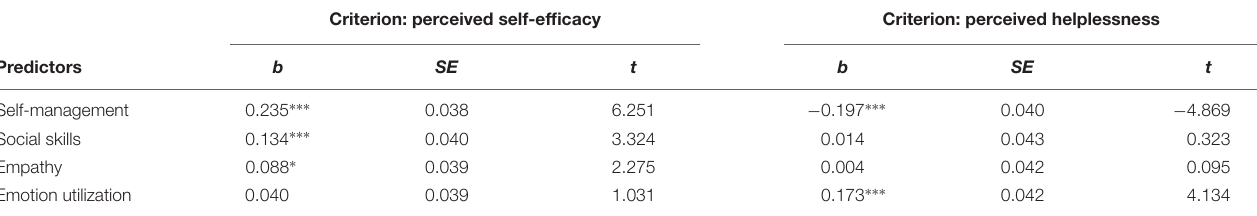
TABLE 3 | Effects of four dimensions of emotional intelligence on perceived self-efficacy and perceived helplessness, respectively. Criterion: perceived self-efficacy Criterion: perceived helplessness